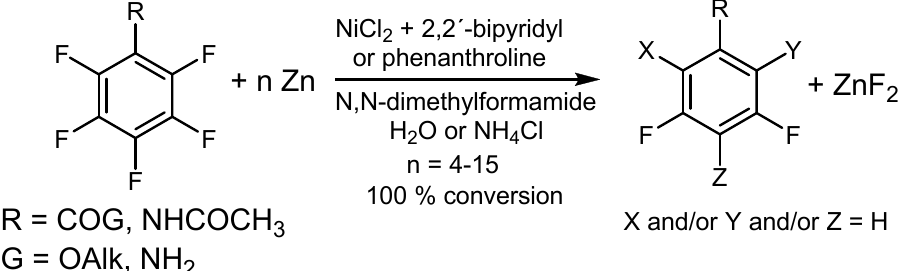
Scheme 13. Regioselective hydrodefluorination of perfluorinated acetanilides or derivatives of per- fluorinated benzoic acids [65,66].